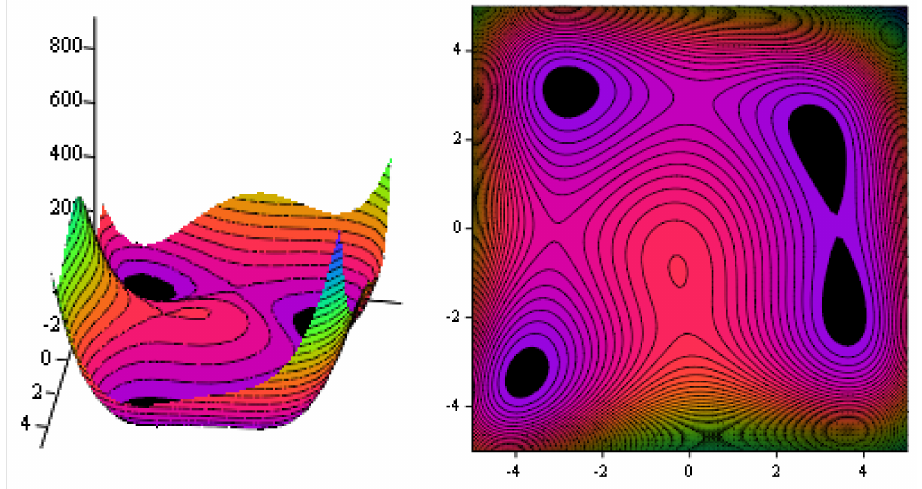
Figure 18. The Himmelblau’s function and its